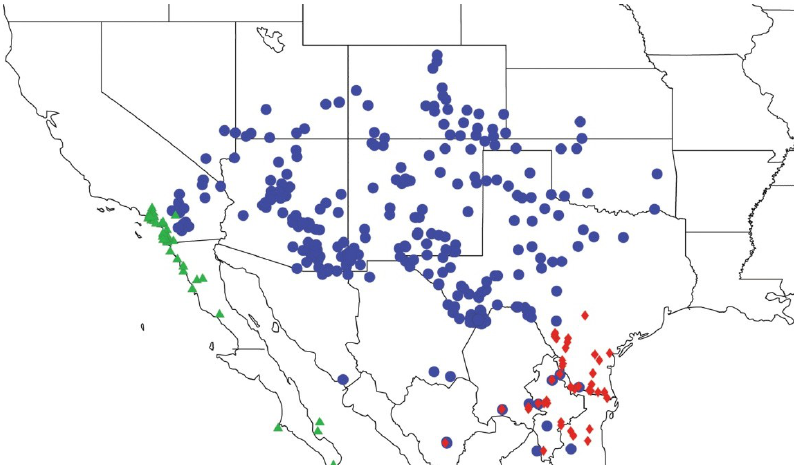
Figure 1. Distribution of Cacama crepitans (green triangles), C. valvata (blue circles) and C. variegata (red diamonds).